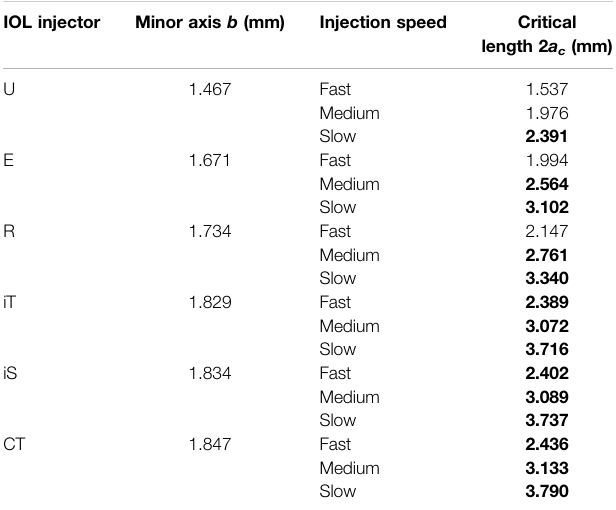
TABLE 2 | Critical incision lengths for six IOL injection systems at various incision speeds. The critical length larger than recommended 2.2 mm are shown in bold.